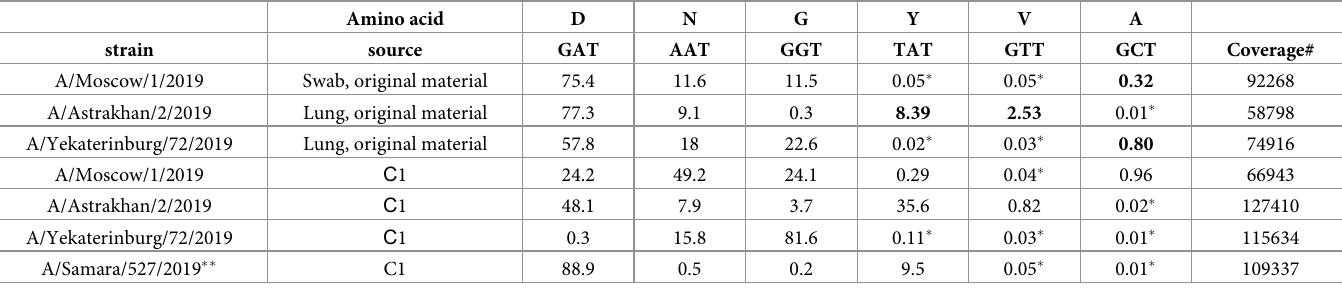
Table 6. Detection of other mutations in 222 position of HA of the A(H1N1)pdm09 viruses.